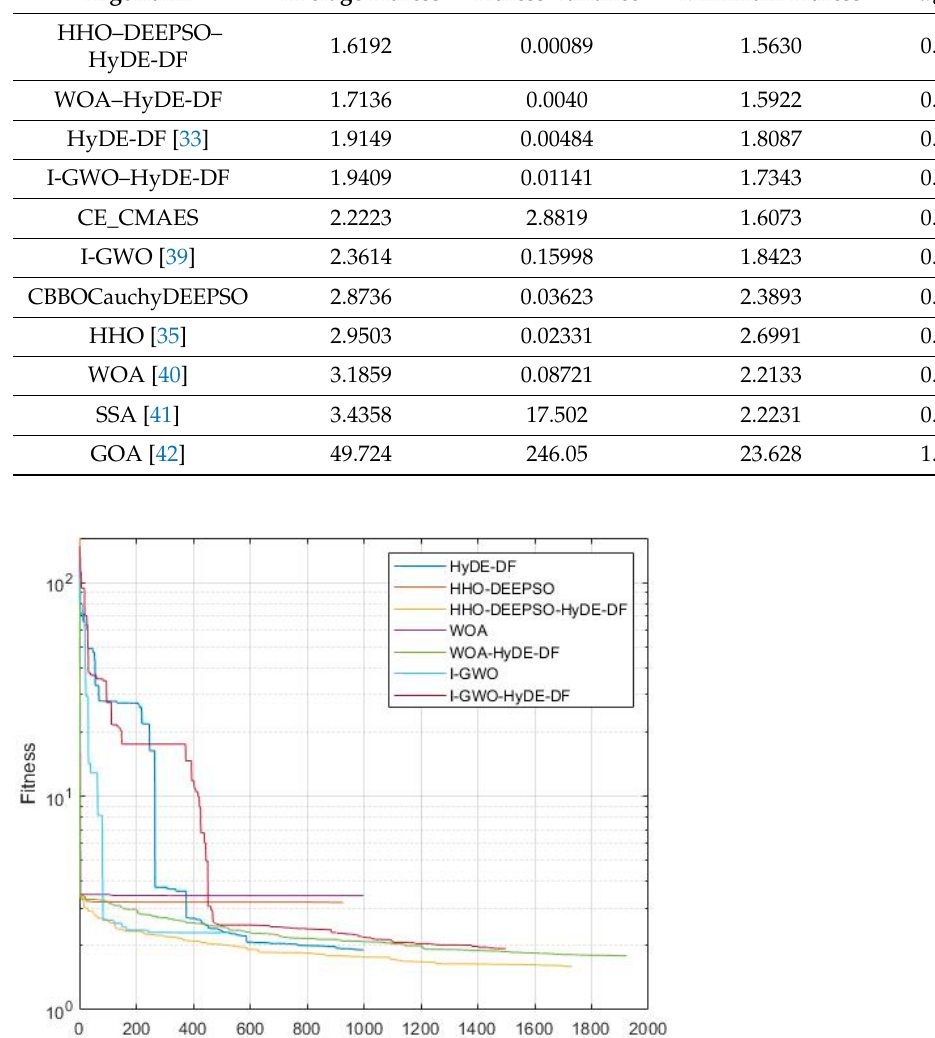
Table 4. Metaheuristic algorithm results over 20 runs.